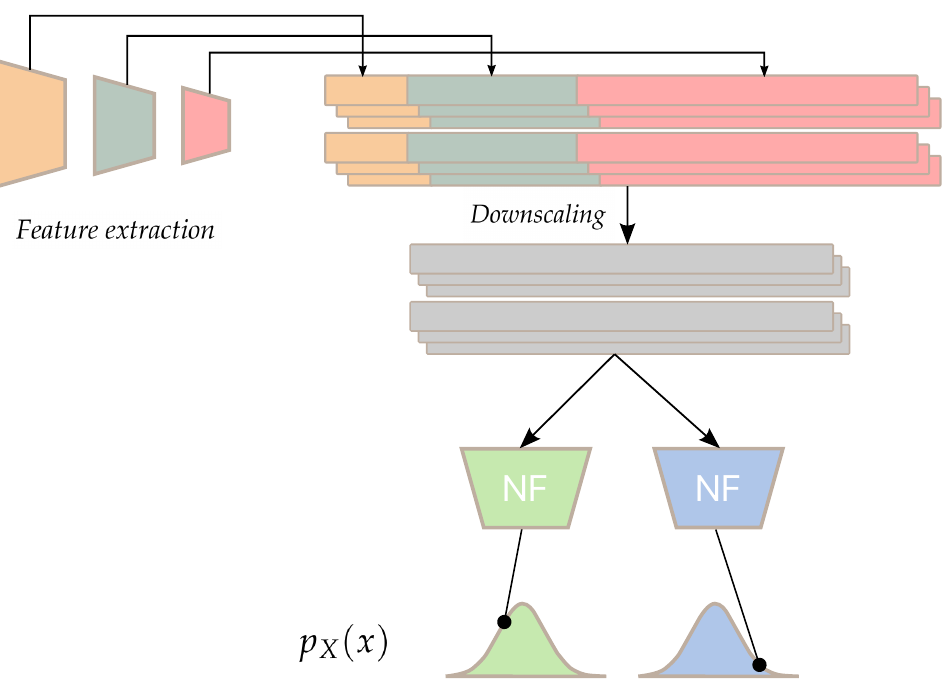
Figure 5. Architecture of the multi-headed model. After extracting and downscaling the features, each model computes the negative log-likelihood of each patch and the final score for a patch is the maximum of all K = 2 predictions.